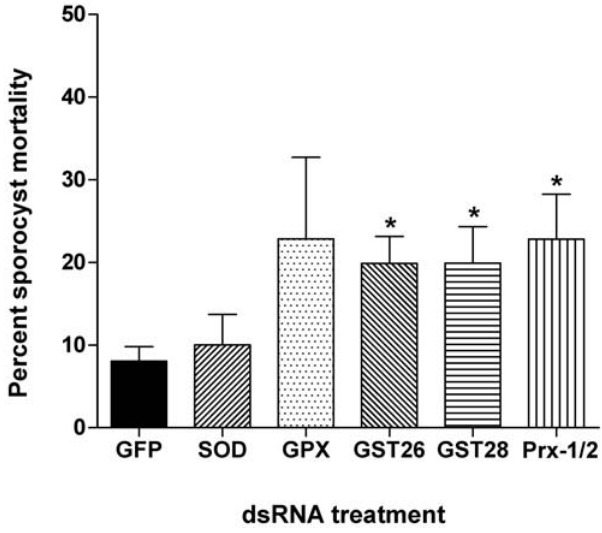
Figure 5. Invitro cell-mediated cytotoxicity (CMC) assay results. Schistosoma mansoni sporocysts, cultured for 7 days in medium containing antioxidant (GPx, Prx1/2, GST26 and 28, SOD) or control GFP dsRNA were incubated for 24 hr with plasma-free hemocytes from the susceptible NMRI snail strain of Biomphalaria glabrata followed by assessment of larval mortality by propidium iodide staining. Co-culture of GST26, GST28 and Prx1/2 dsRNA-treated sporocysts with snail hemocytes resulted in small, but significant increases in percent larval mortality when compared to GFP dsRNA controls. The GPx dsRNA- treatment exhibited a nonsignificant increase in larval killing, while mortality of SOD dsRNA-treated sporocysts showed no difference compared to GFP dsRNA controls. * P # 0.04; N=4.